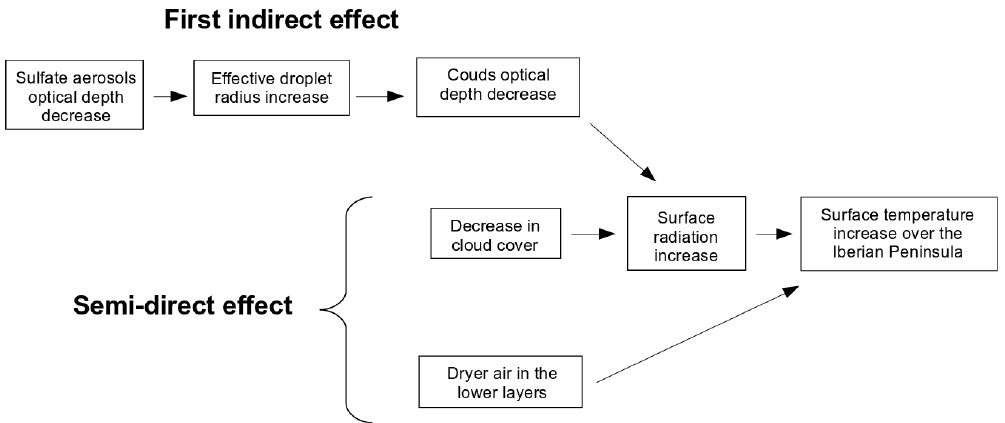
Figure 17. Summary of the anthropogenic aerosol role on the projected surface temperature increase over the Iberian Peninsula in summer between the periods 1971–2000 and